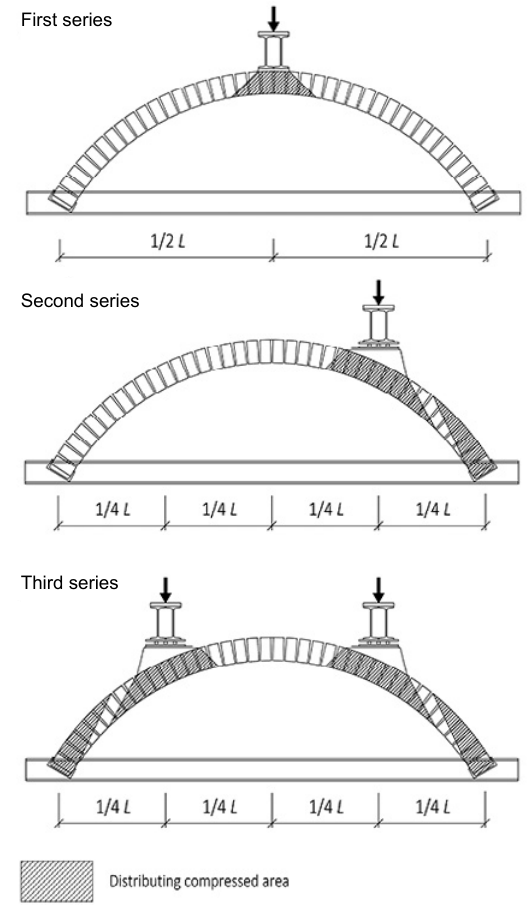
Figure 2. Loading schemes of vaults and the distribution of load in